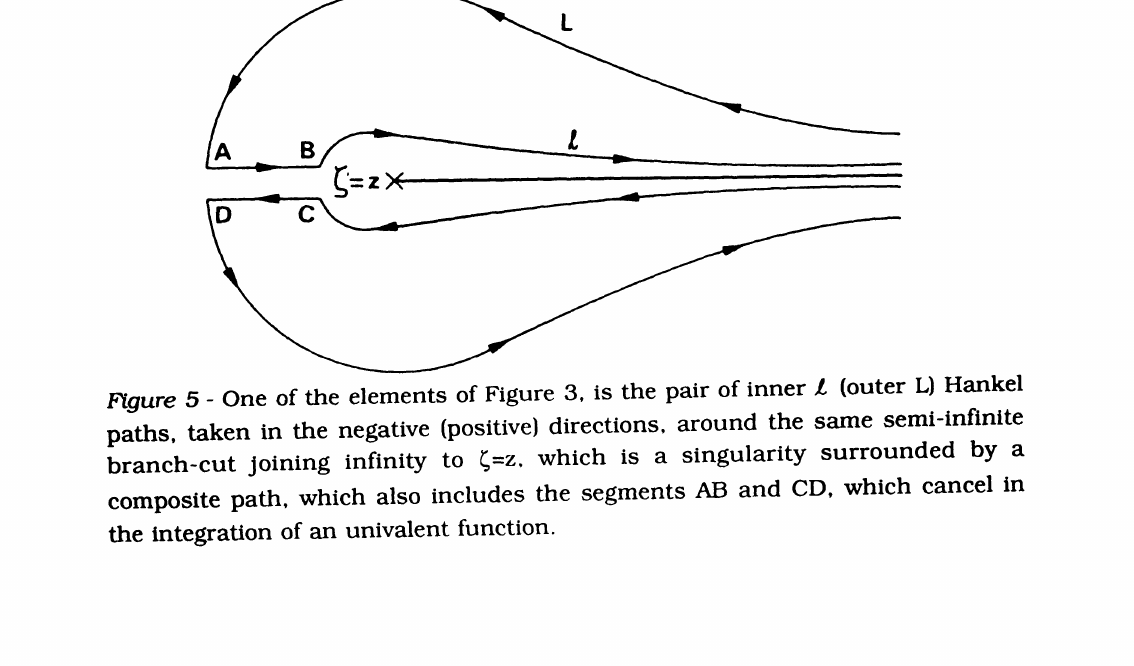
Figure 3- The ’Liouville’ differintegration of a function with an isolated =z, uses an inner and an outer L Hankel path, both about the singularity at . =z same semi-infinite branch-cut joining to infinity, which intersect the inner DE and outer D closed-loop boundaries, of the doubly-connected regions of convergence of the generalized Teixeira (Laurent) series, respectively at the and points